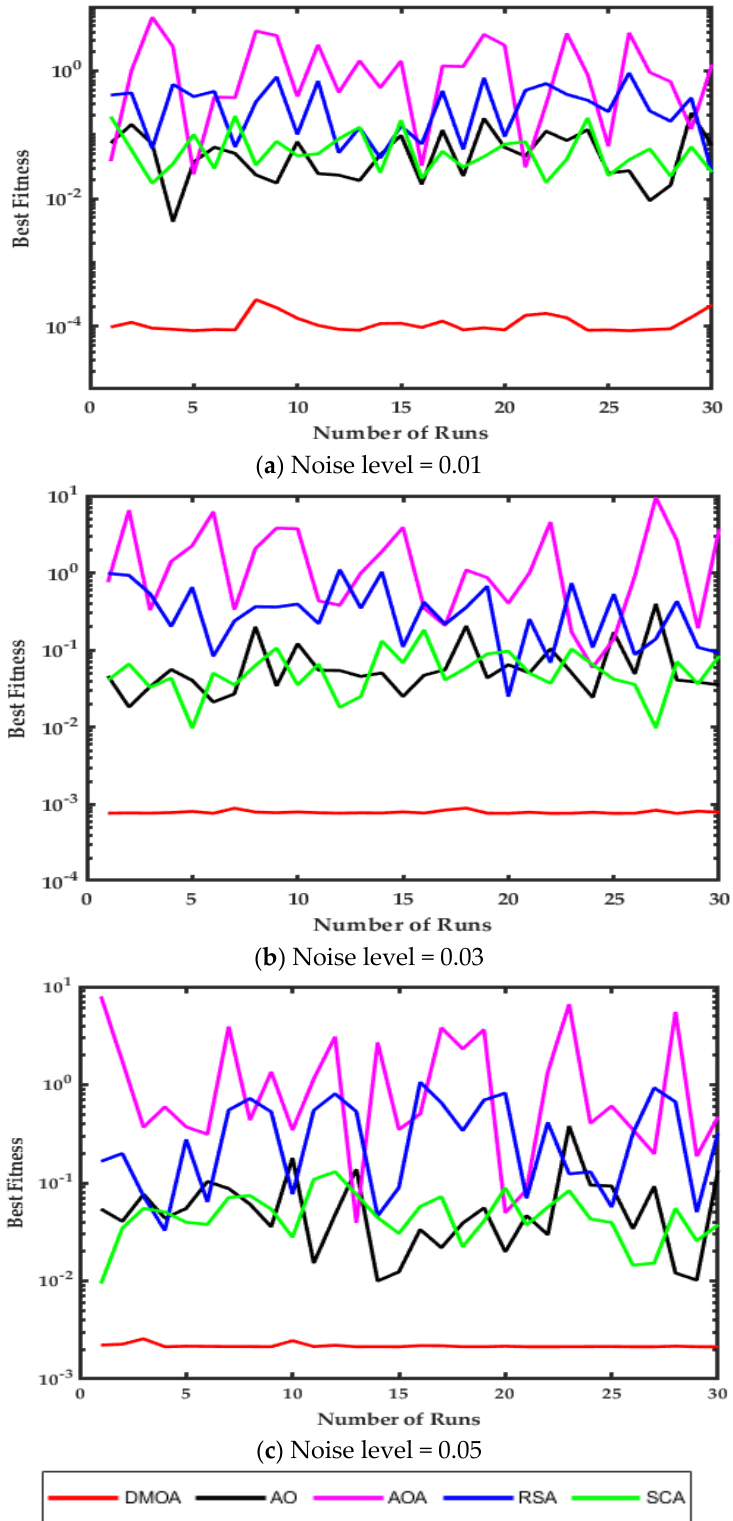
Figure 6. Statistical analysis plots for the DMOA, AO, AOA, RSA and SCA for Np = 25, T = 250. Figure 7 shows a comparison of the boxplots for the average fitness values of the DMOA against those of the AO, AOA, RSA and SCA for all variations of T, Np and noise